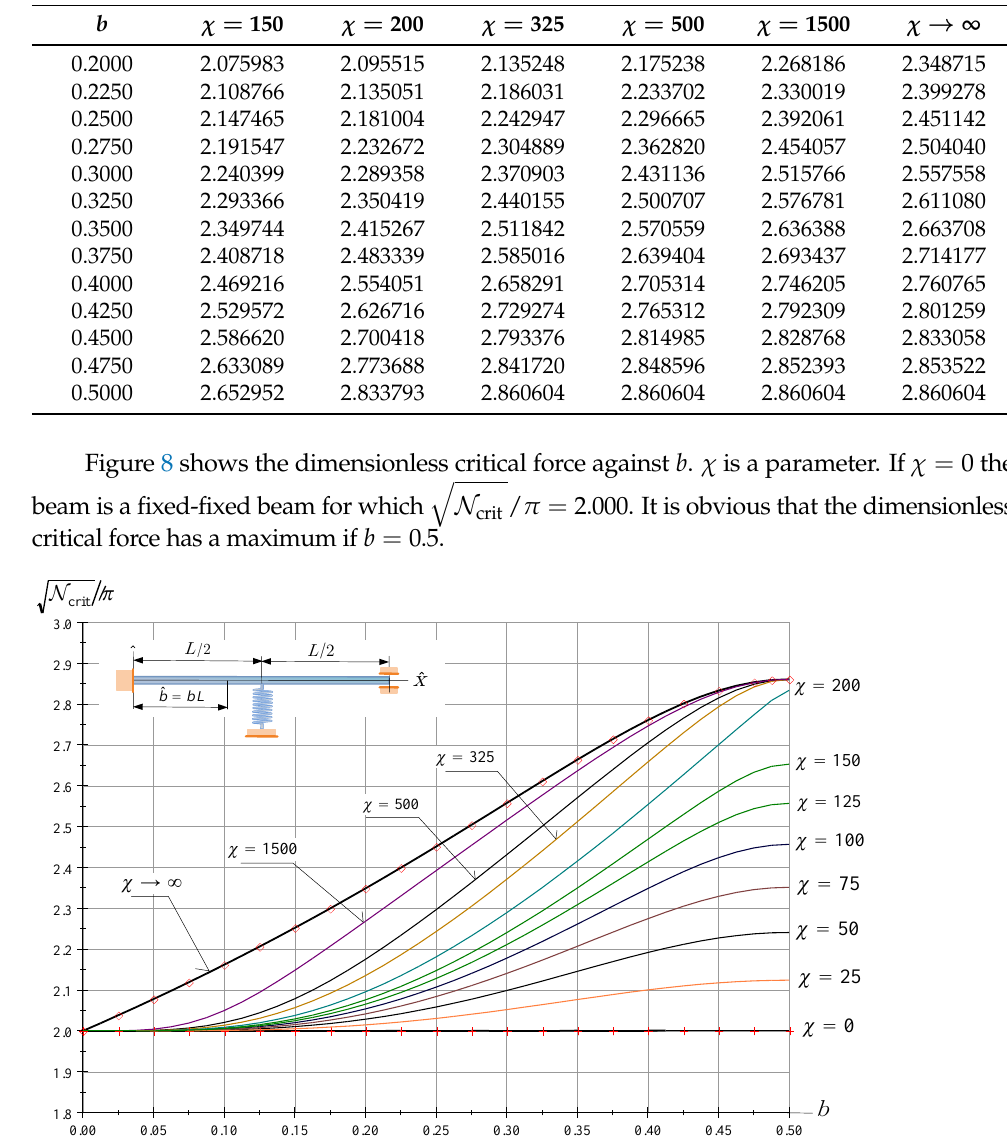
Figure 8. The dimensionless critical force of FssF beams as a function of b ; χ is a